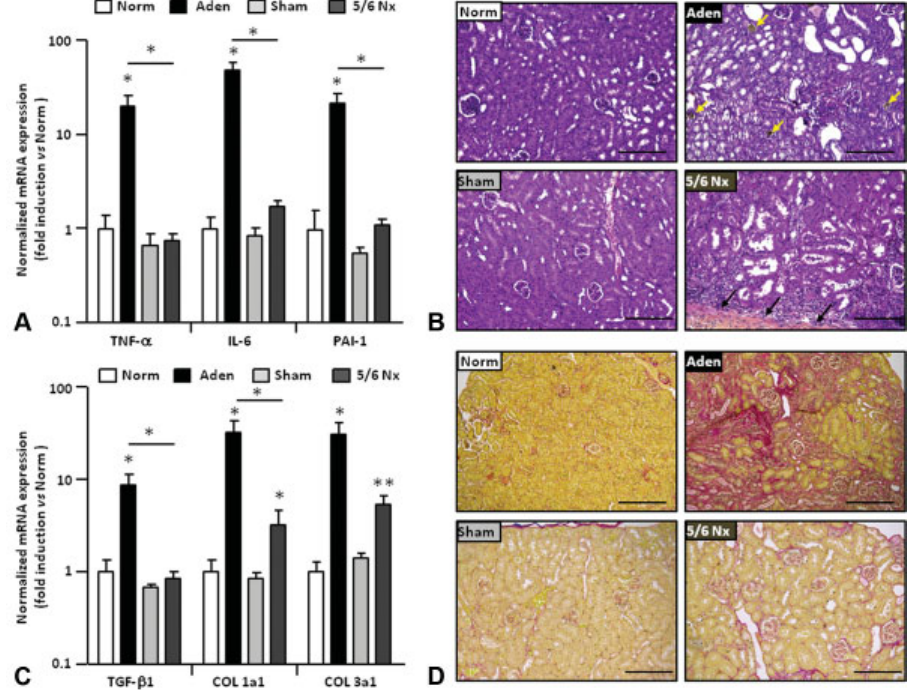
Fig. 1 Renalin fl ammationand fi brosisintwomodelsofmouseCKD.( A )Expressionof TNF- α ,IL-6,andPAI-1 mRNAinthekidneysisolatedfrommicefedwith adenine 0.25% (Aden) or with normal diet (Norm) and from sham-or 5/6Nx-operated mice. ( B ) Representative H&E staining of kidney sections. The yellow arrows point crystals of 2,8-dihydroxyadenine precipitated in tubules and the black arrows indicate the limit of injury causes by cauterization in residual kidney.( C )Kidneyexpressionof TGF- β 1,COL1a1,andCOL3a1 mRNAinmicefedwithadenine0.25%(Aden)or withNormandfromsham-or5/6Nx-operated mice.( D )RepresentativeSiriusredstainingofkidneysectionsshowingcollagendepositionrelatedto fi brosis.CKD,chronickidneydisease; COL1a1 ;collagen type1,alpha1;5/6Nx,5/6thnephrectomy;H&E,hematoxylinandeosin;IL-6,interleukin-6;mRNA,messengerribonucleicacid;PAI-1,plasminogenactivator inhibitor-1; SEM, standard error of the mean; TGF- β 1; transforming growth factor-beta 1; TNF- α , tumor necrosis factor-alpha. Data are expressed as mean (cid:3) SEM, n ¼ 4 – 6/group. (cid:4) p < 0.05; (cid:4)(cid:4) p < 0.01. Scale bars ¼ 200 μ ( ► Fig. 1D ).Theexpressionofproin fl ammatoryandpro fi brotic genes was not induced in the liver of mice fed with adenine,